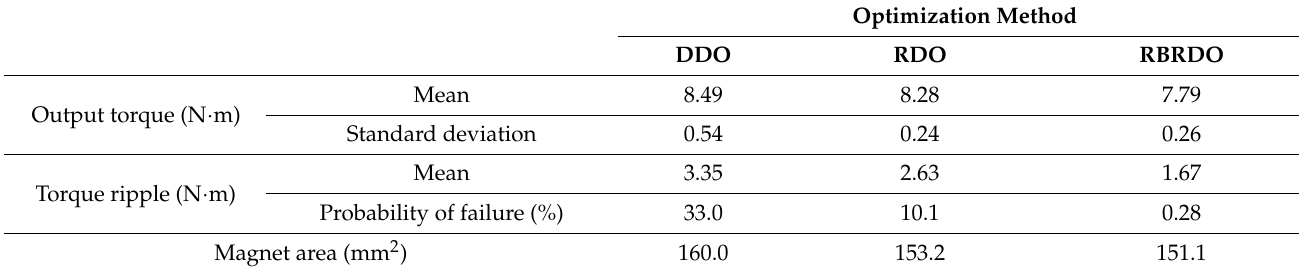
Table 7. Comparison of DDO, RDO, and RBRDO results.